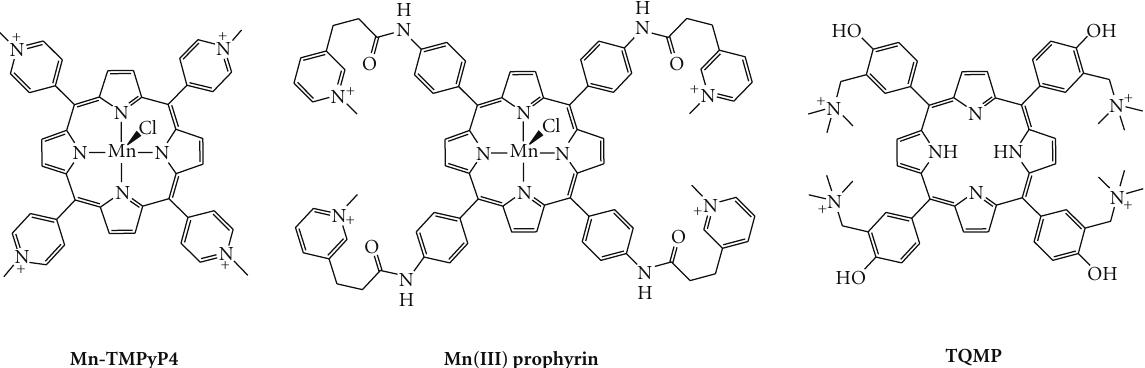
Figure 7: Chemical formulae of porphyrin-based G-quadruplex ligands.